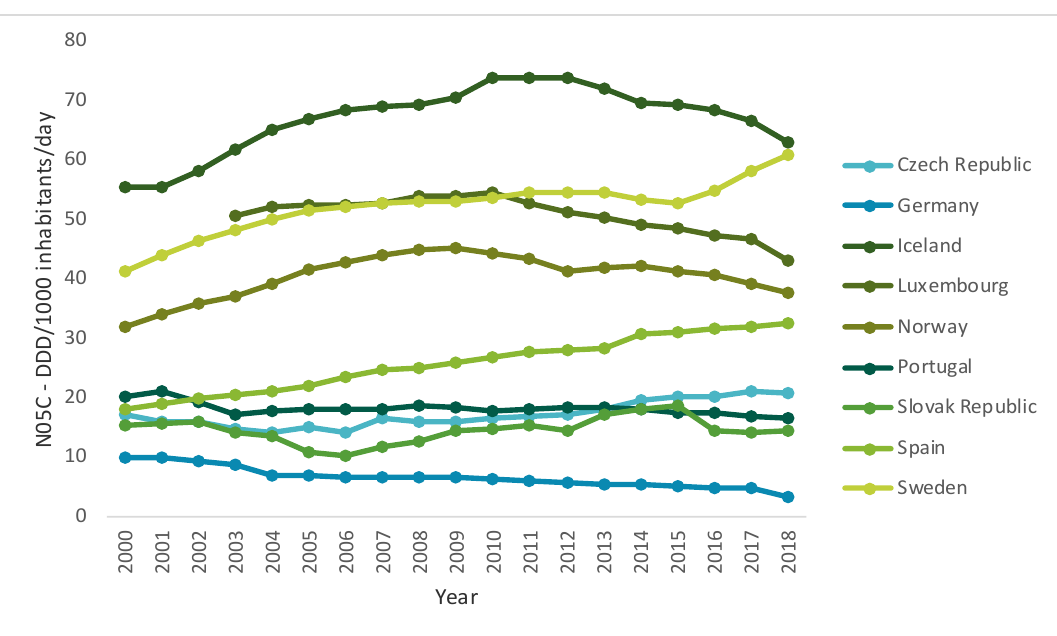
Figure 2. Use of sedatives and hypnotics (N05C) in some OECD countries from 2000 to 2017 (DDD/1000 inhabitants/day) (data from [24]).